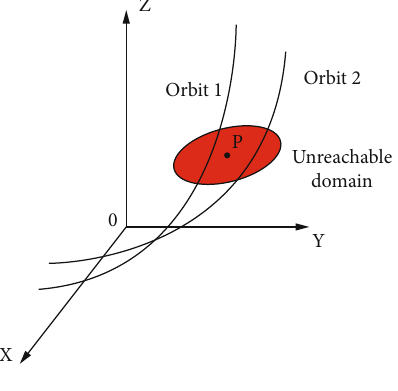
Figure 3: Illustration of thrust